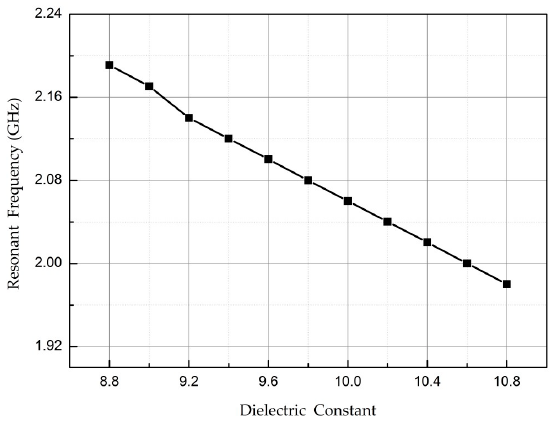
Figure 4. Simulated relationship between the dielectric constant and resonant frequency.